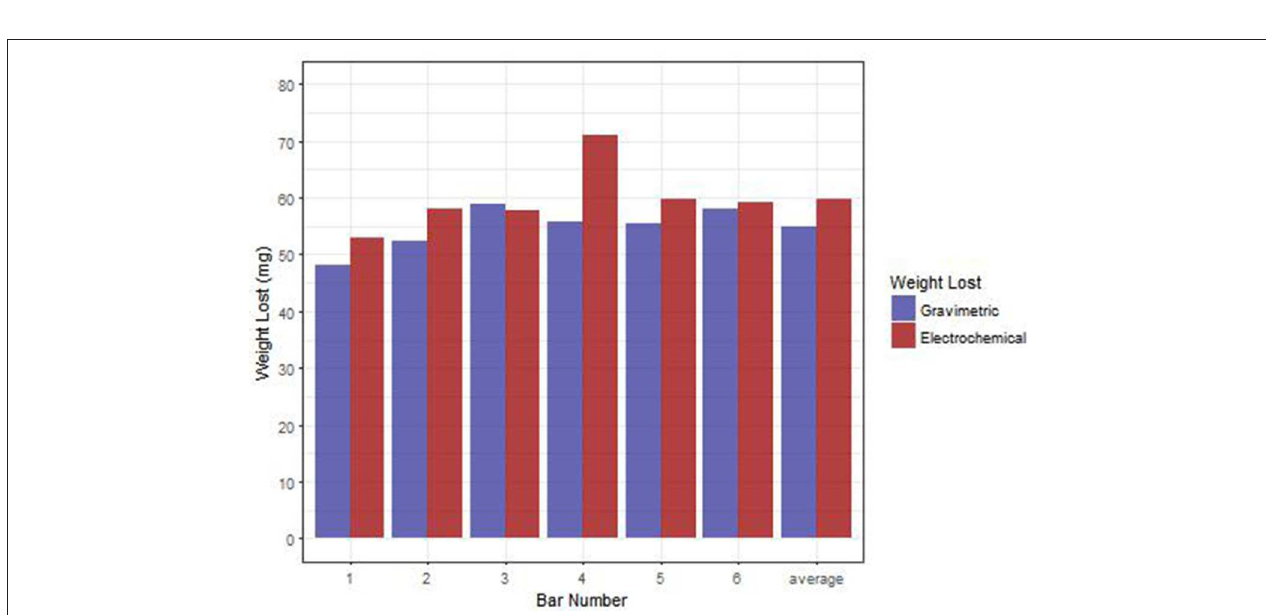
FIGURE 5 | Gravimetric weight losses in steel bars submerged in water.